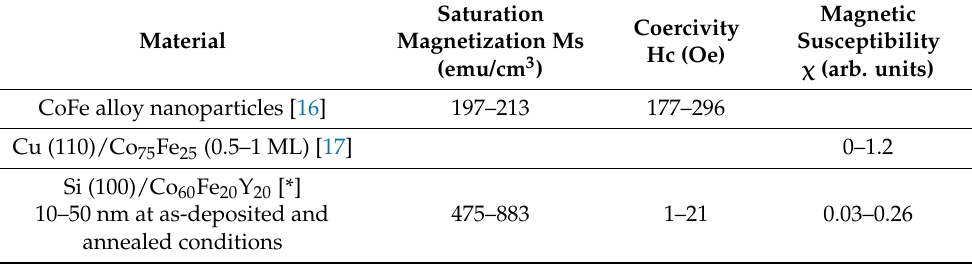
Table 1. Significant properties for Co 60 Fe 20 Y 20 and Co 75 Fe 25 materials.